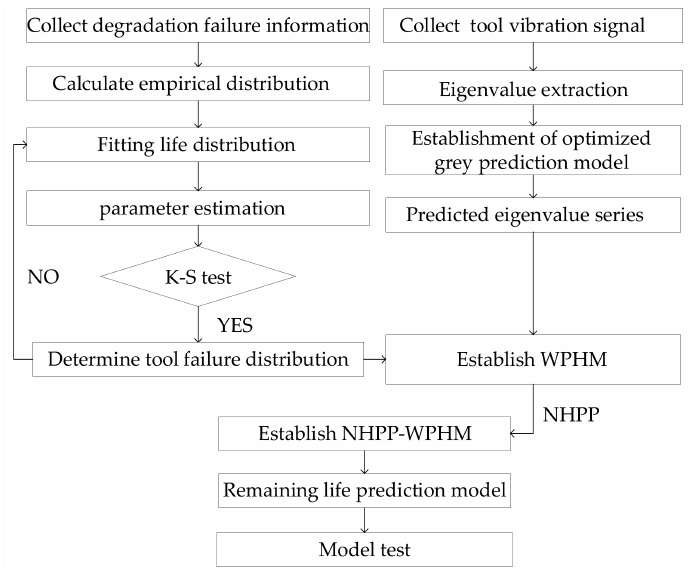
Figure 1. Flow chart of the tool remaining useful life prediction based on